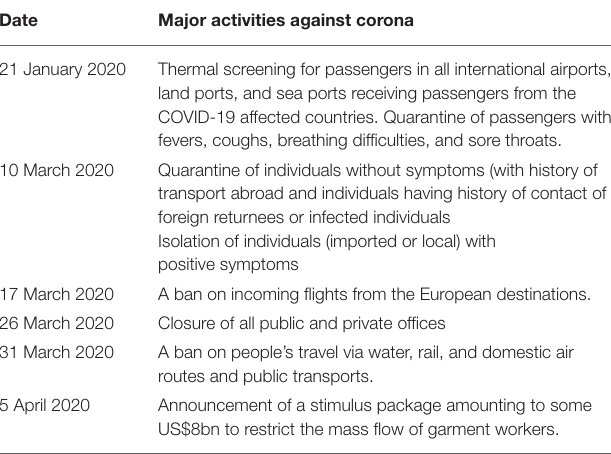
TABLE 1 | Measures taken by the Government of the People’s Republic of Bangladesh.